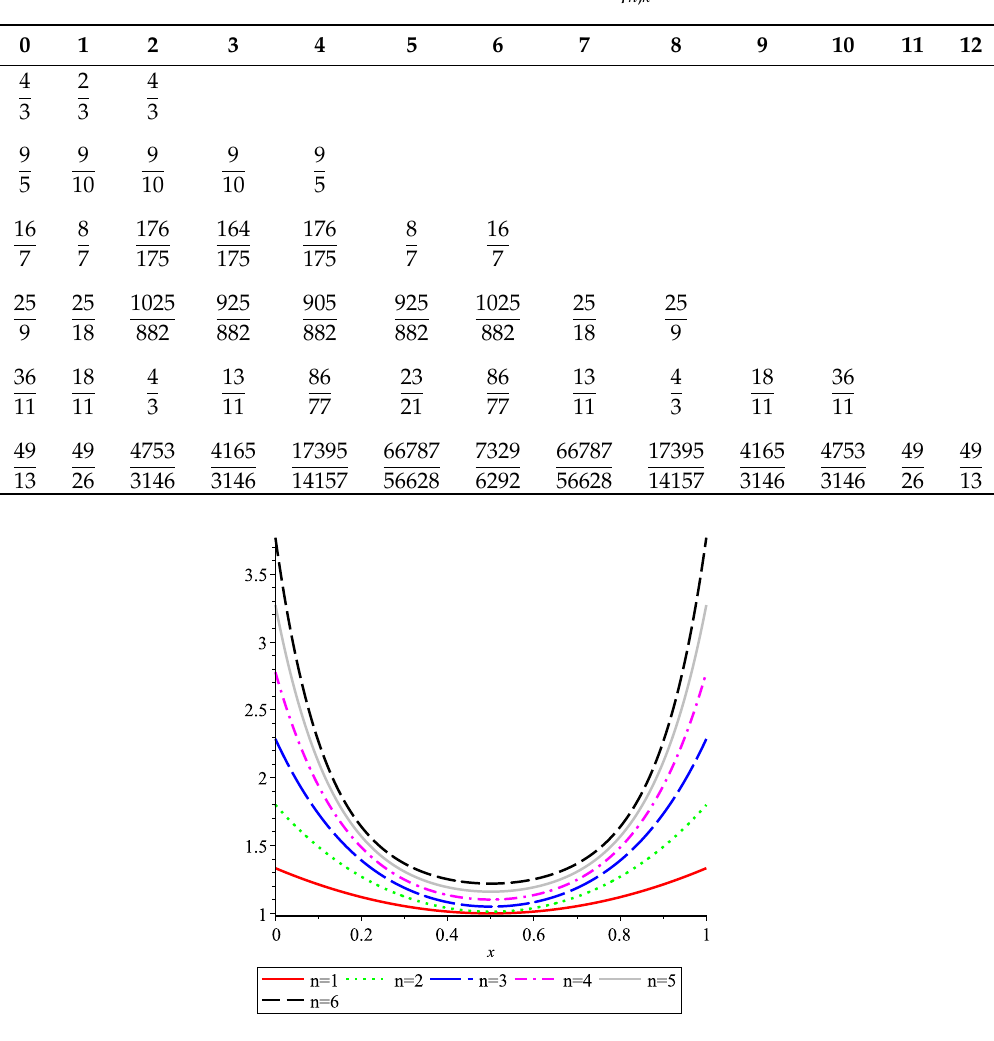
Figure 2. Graphics of S n for n =